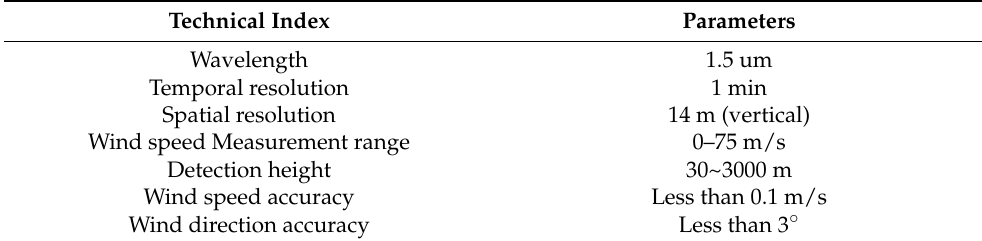
Table 2. Parameters for the Doppler wind